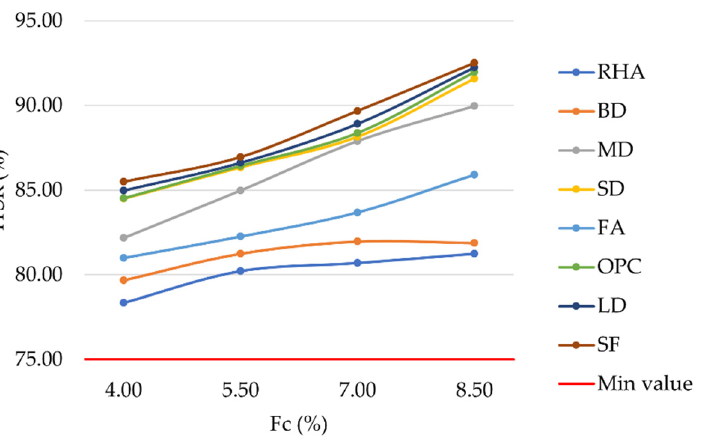
Figure 10. Indirect tensile strength ratio vs. filler content for mixtures prepared with conventional and waste fillers.